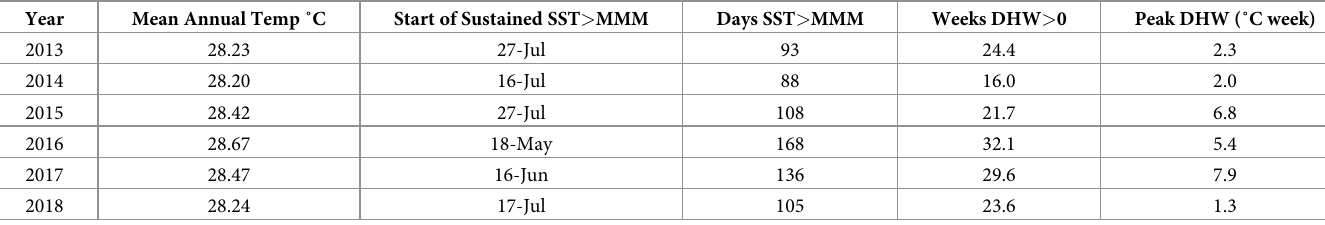
Table 2. Summary of annual (calendar year) temperature data at Coral